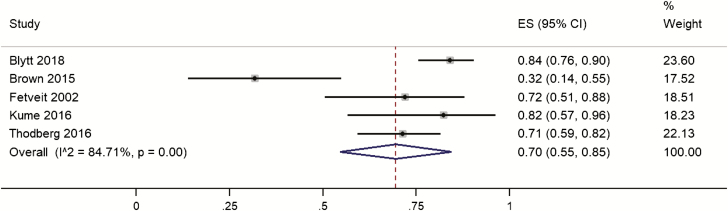
Forest plot of the prevalence of sleep disturbances on actigraphy in people with dementia living in care homes measure. ES, effect size.